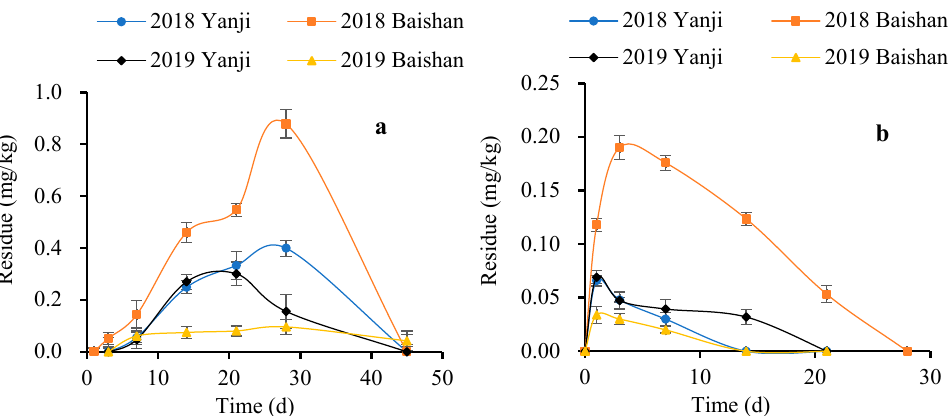
Figure 3. Change of concentration of difluoroacetic acid and 6-chloronicotinic acid in ginseng plants: ( a ) difluoroacetic acid; ( b ) 6-chloronicotinic acid. The concentration of initial deposits of FPF in soil was 0.66–0.91 mg/kg, which dropped to below the LOQ (0.01 mg/kg) after 45 d. The calculated half-lives of FPF in soil